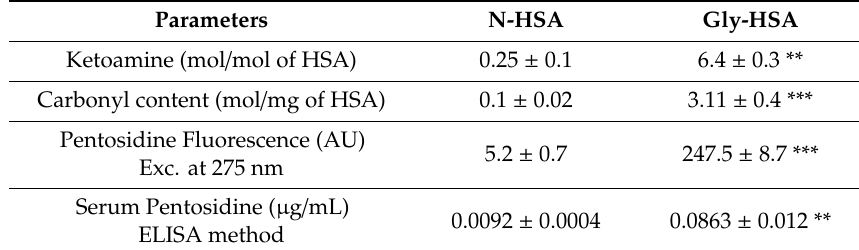
Table 1. Chemical and structural characterizations of native human serum albumin (N-has) and glycation of human serum albumin